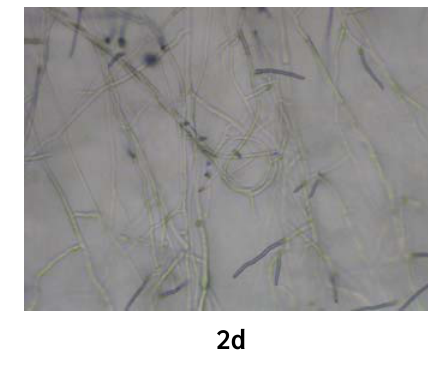
Figure 2. Microphotograph (800×) of hyphal morphology of F. oxysporum treated with 2d.